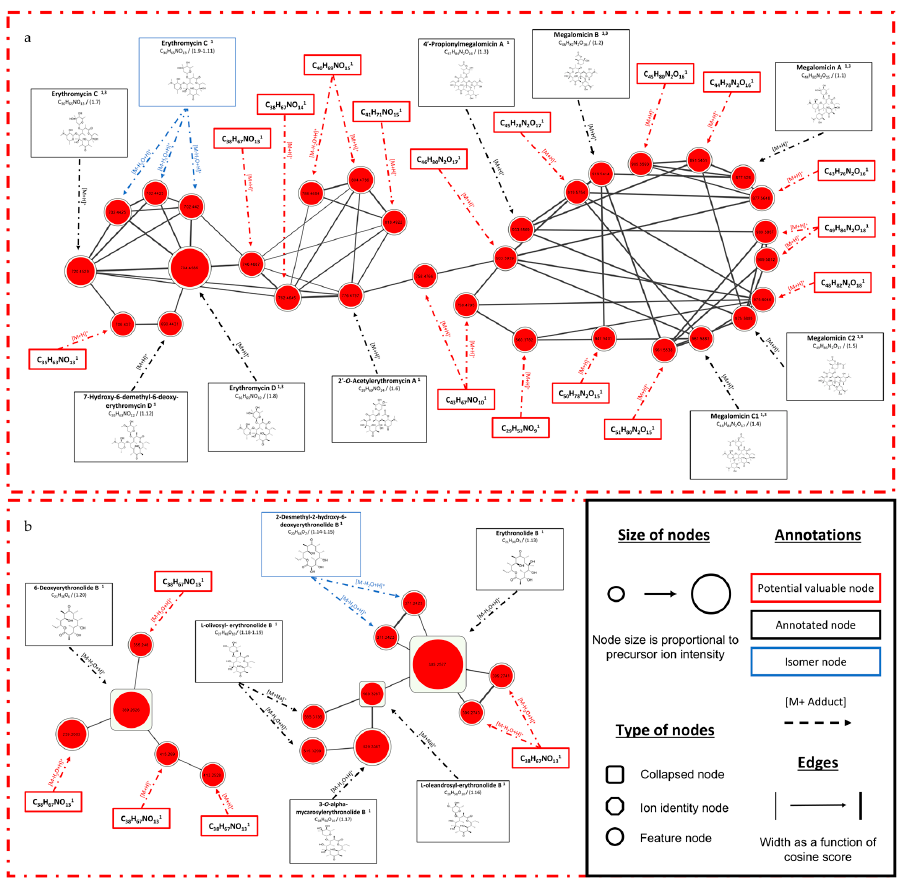
Figure 3. Main annotated clusters from the crude extract of Micromonospora fluostatini SH-82 (red node). ( a ) Main cluster representing the natural product class of erythromycins and ( b ) set of